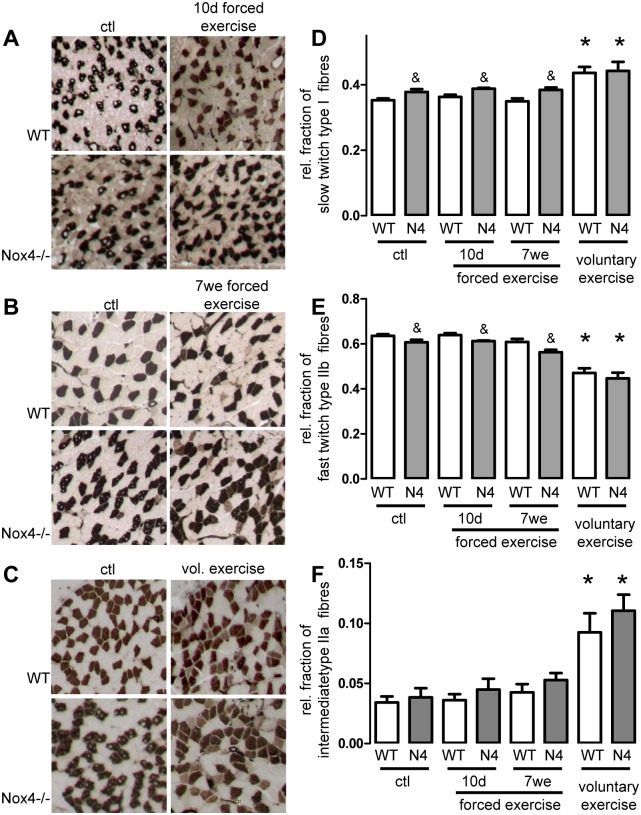
Exercise-induced muscle fibre switch is independent of Nox4.(A-C) Representative images of sedentary and exercised soleus muscle stained for myosin ATPase to determine fibre-type distribution. (D-F): Quantification of slow (dark), fast (light) and intermediate fibres ratio per field of view. mean±SEM (n>5). *p <0.05 (ctl vs. Ex.); &p<0.05 (WT vs. Nox4-/-)